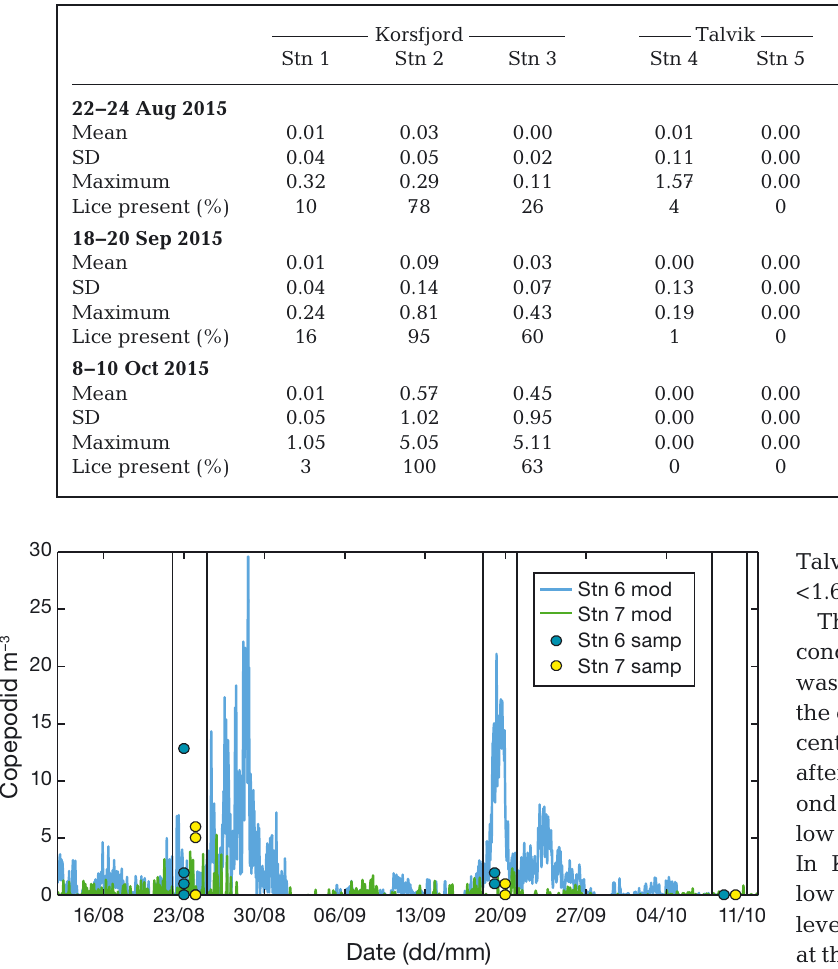
Fig. 6. Modelled (mod) and sampled (samp) lice copepodid concentrations at sampling Stns 6 and 7 in the inner part of Øksfjord (see Fig. 5), August to Oc- tober 2015. Graphs show model estimates of the number of salmon lice cope- podids per cubic meter in grid cells (each of 160 × 160 m 2 ) representing the sampling positions at depth interval 1 to 2 m. Dots represent sampled lice concentrations (Table 2) from the 3 cruise periods, marked with vertical lines